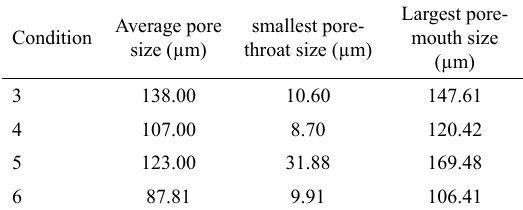
Table 3. Summary of porosity characteristics in samples sintered at